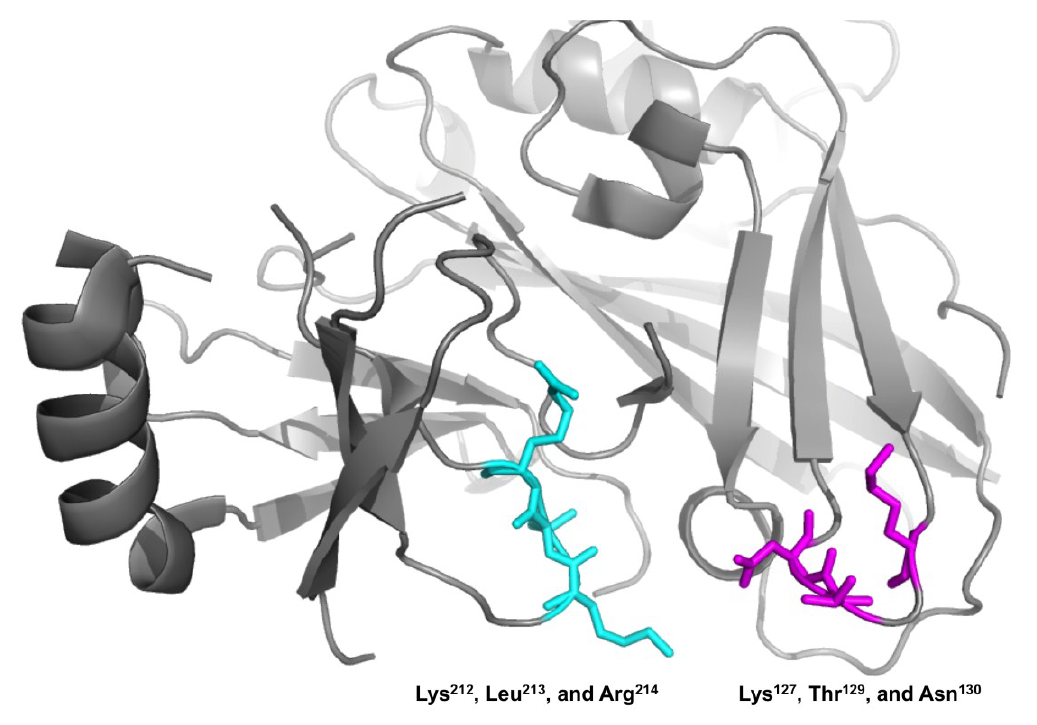
Figure 9. The Lys 127 , Thr 129 , Asn 130 N-terminal loop region is on the same interface as a C-terminal residue sequence previously identified to be important for VP40 budding. Lys 127 , Thr 129 , Asn 130 (magenta) in the NTD (PDB ID: 4LDB) are adjacent and on the